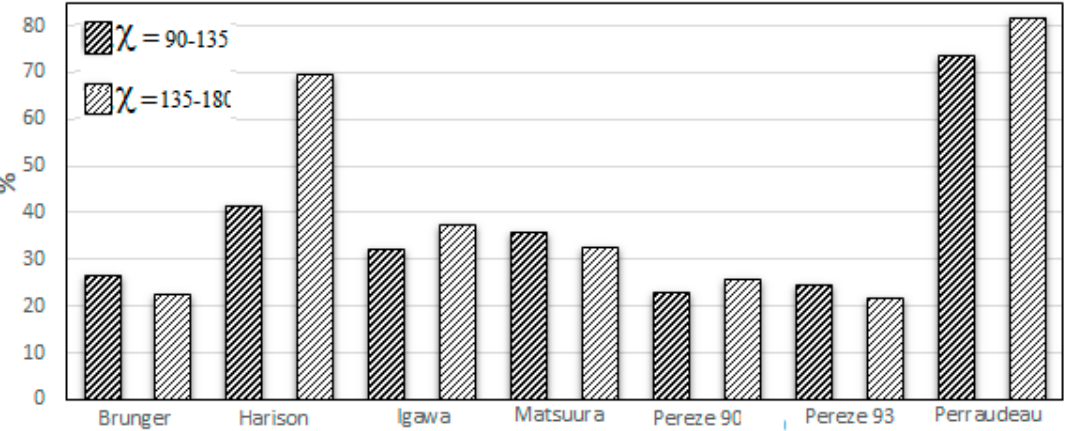
Figure 10. RMSE of the investigated models as a function of the angular distance between the sky point and sun, χ (90° to 180°).